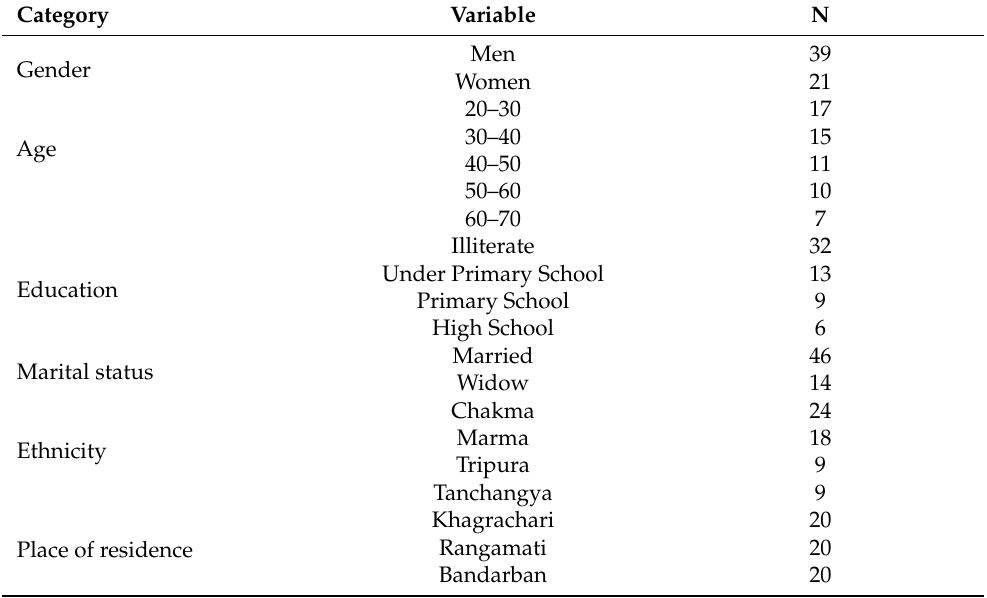
Table 5. Distribution of the demographic profile of the